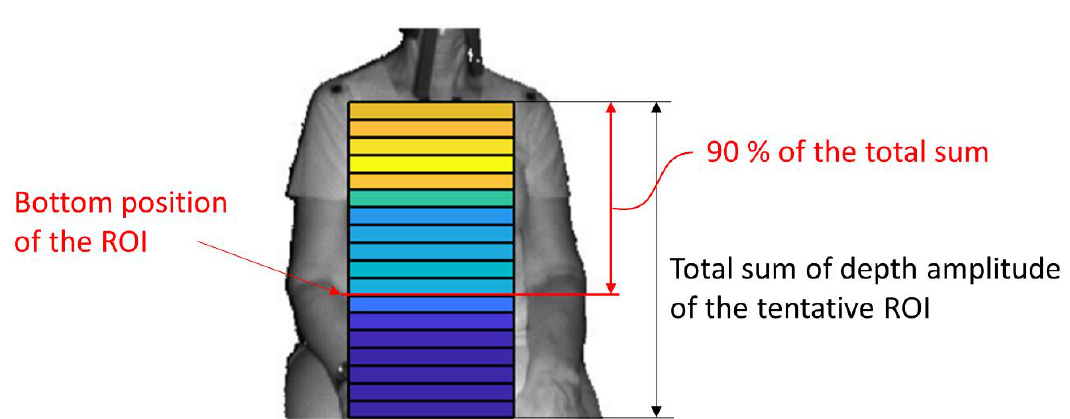
Figure 3. Acquiring the depth amplitude of each row.